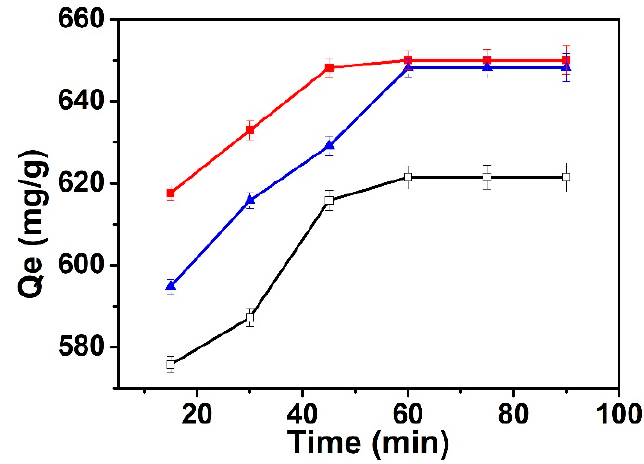
Figure 8. Adsorption capacity towards Ni 2+ of gauze@PEI 0.4 /PEGDE 1 /TETA 0.6 ( ■ ); gauze@PEI 0.2 /PEGDE 1 /TETA 0.8 ( □ ) and gauze@PEI 0.2 /PEGDE 1 /BAP 0.8 ( ▲ ). Surprisingly, as seen in Figure 8, gauze@PEI 0.4 /PEGDE 1 /TETA 0.6 exhibited the best adsorption